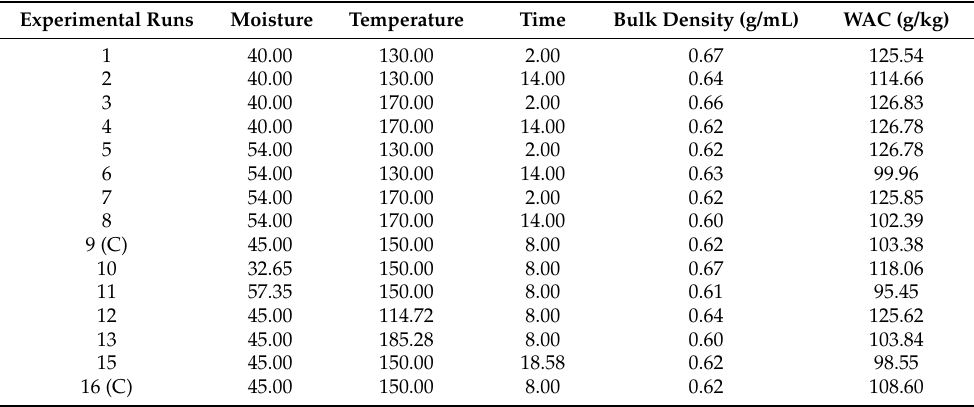
Table 2. Bulk density and water absorption capacity (WAC) of moisture conditioned follow by infrared heating of cowpea seeds for different experimental